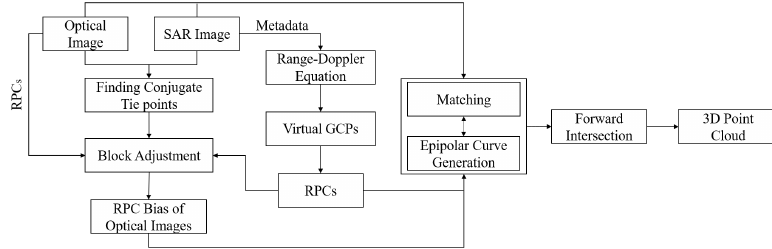
Figure 4. Framework for 3D reconstruction from synthetic aperture radar (SAR)-optical image pairs